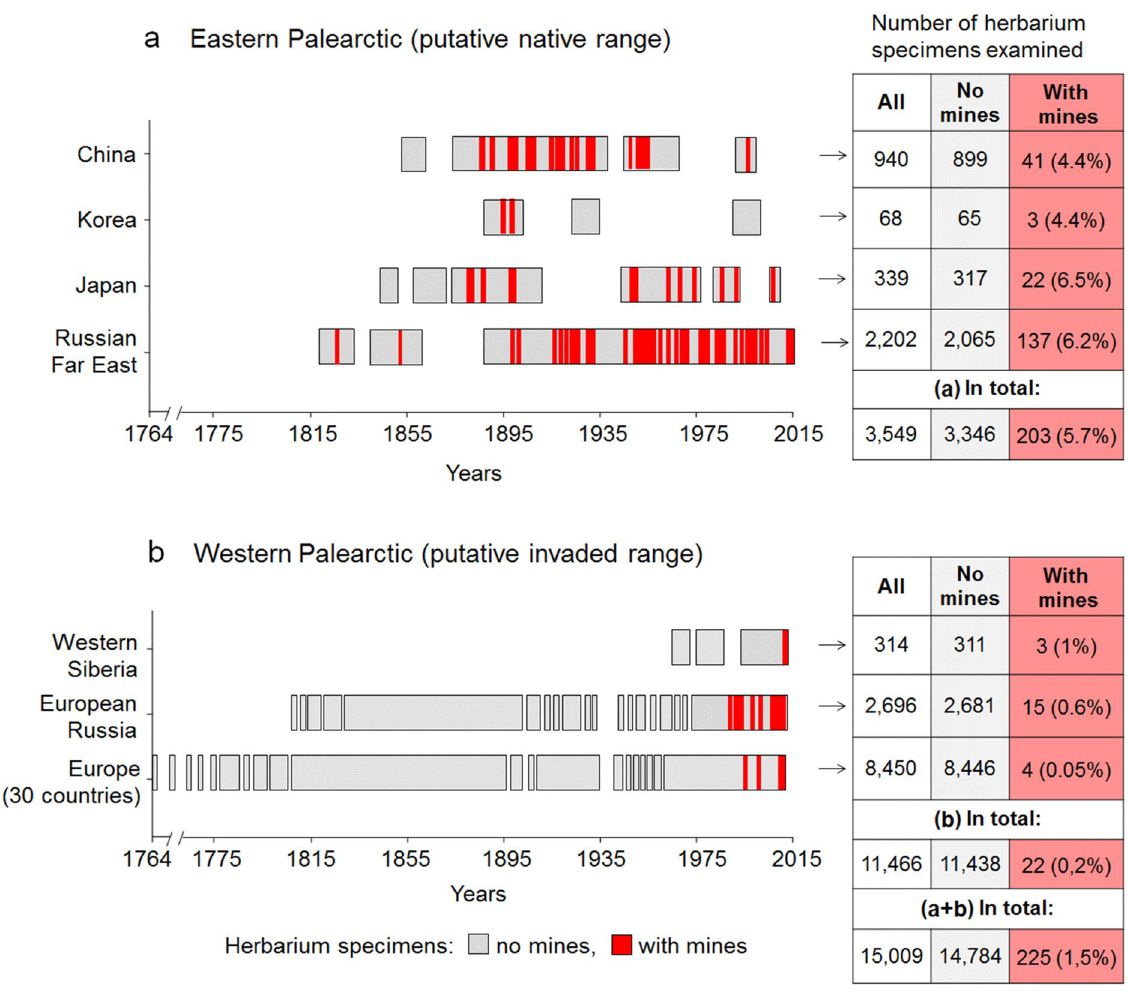
Figure 2. The presence of Phyllonorycter issikii mines in the herbarium specimens collected in the putative native ( a ) and invaded ( b ) ranges over the past 253 years (1764–2016). The number of herbarium specimens with and without mines and the percentage of the specimens with mines in each region or country from all herbarium specimens examined in a region or country (in brackets) are given next to each graph. The total number of herbarium specimens, including those with and without mines, is given for Eastern (a) and Western Palearctic (b) separately and altogether (a + herbarium specimens with mines (10%; 22/225) from the putative invaded region in Western Palearctic, with the majority of herbarium specimens with mines (7% 15/225) from European Russia (Fig. 2b). The average number of leaf mines per herbarium specimen found in native (5.68 ± 0.77) and invaded regions (6.09 ± 1.70) was not significantly different (Mann–Whitney U-test: U = 20,145; Z = 0.43; p = 0.43). However, the infestation rate by Ph. issikii, i.e. percentage of leaves with mines per herbarium specimen was statistically higher in the West than in the East: 35% ± 8.19 versus 23% ± 1.94 (Mann–Whitney U-test: U = 1339; Z = 2.30; p = 0.02). Leaf mines from the East were significantly older than those from the West (Mann–Whitney U-test: U = 81; Z = − 4.4; p < 0.001). Indeed, Ph. issikii mines from the West were found on herbarium specimens collected exclu- sively in the last three decades (1987–2015) (Figs. 2a, S1), whereas in East Asia, they were detected in herbarium samples dating back to 1830 (Figs. 2b, S1). The oldest mines were revealed in the pressed lime leaves sampled in the RFE: in Primorsky Krai, Sikhote-Alin Nature Reserve in 1830 (one empty mine), followed by the finding in Amur Oblast (village Busse, 1.5 km from the border with the Chinese province Heilongjiang) in 1859 (the mine contained a larva that was identified as Ph. issikii by DNA barcoding). These archival mines were 191- and 162-year-old respectively, and thus they dated 133 and 104 years before Ph. issikii description from Japan (1963). The time lag between the earliest mine record on the East (1830) and that on the West (1987) was 157 years. We found six European herbarium specimens with eleven mines of the polyphagous moth Phyllonorycter messaniella (Fig. 1; Table S1). Seven out of eleven mines were assigned to Ph. messaniella by their morphology, i.e. presence of one distinct longitude fold on the epidermis covering the mines. However, the remaining four mines were at an early stage of development and the fold was not visible therefore DNA barcoding was used to identify them (see “Results” section below).